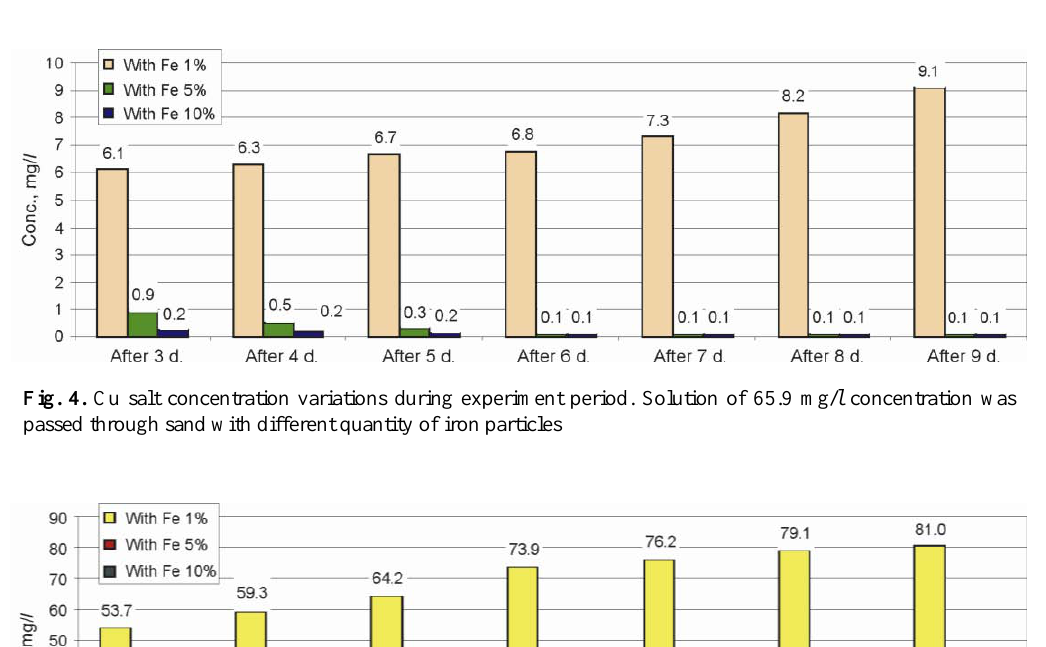
Fig. 3. Variations of Cu salt concentration during the period of the experiment. Solution was passed through sand without iron filings providing initial concentrations of 65.9 and 232.1 mg/ l